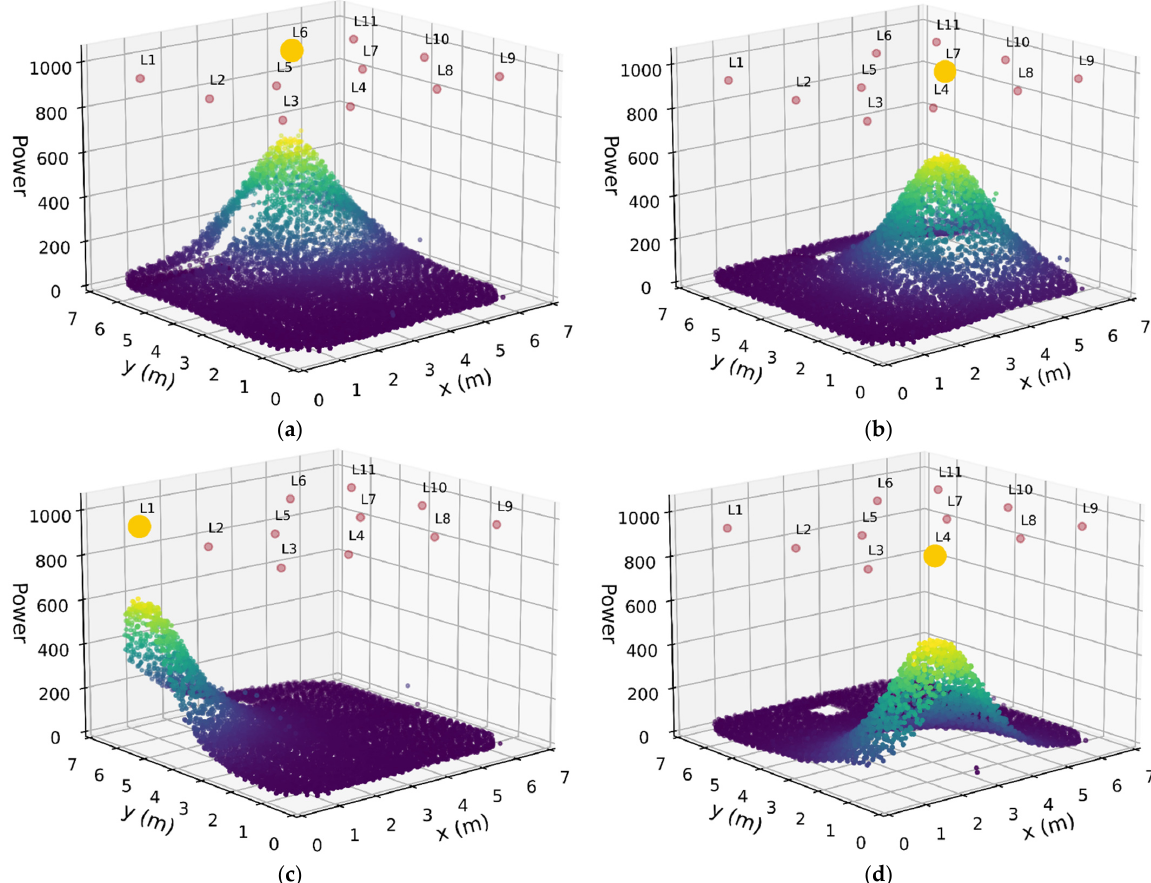
Figure 14. RSS plots for luminaires 6 7, 1, and 4 in ( a ), ( b ), ( c ) and ( d ) respectively. The signal is largest when the sensor is directly beneath and falls off as distance increase. No data were collected at the location of the pilar which can be seen clearly in ( d ).